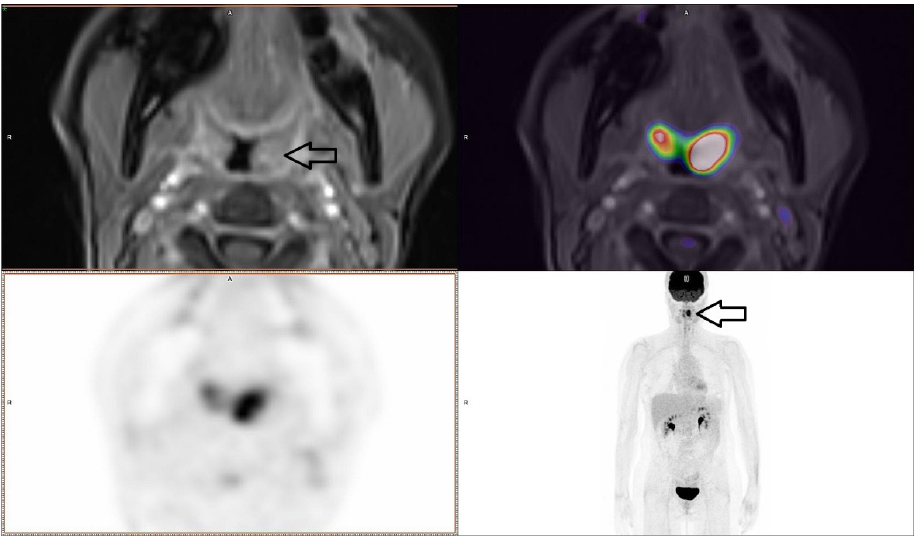
Fig. 2. 18F-FDG PET/MRI scan shows FDG signal accumulation at the left tonsil area subsequently histologically verified as left tonsillar carcinoma (arrow) - MRI in transversal view (left upper), PET image in transversal view (left lower), fused MRI and PET (right upper) and whole-body PET (right